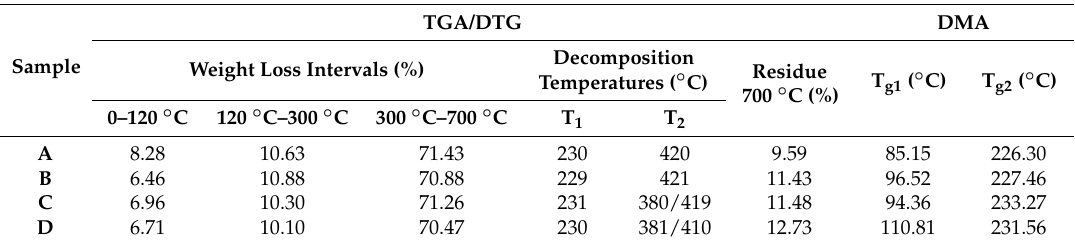
Table 2. TGA/DTG and DMA results for the obtained hydrogel samples.